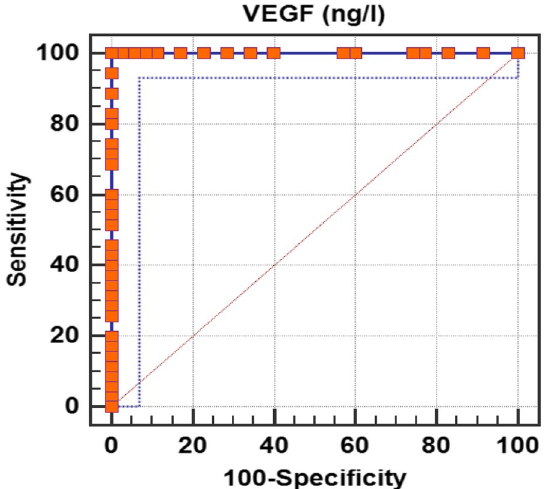
Fig. 6 ROC curve and area under the curve showing sensitivity and specificity of VEGF in AS